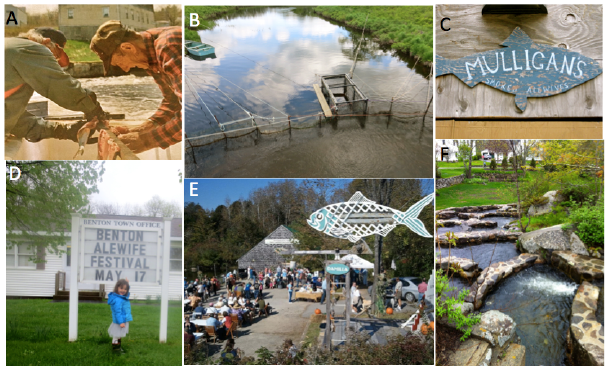
Fig. 2. A representation of various aspects of alewives ( Alosa pseudoharengus ) in Maine. (A) Two men smoking alewives in East Machias, Maine (ca. 1980, courtesy of Bucky Davis).